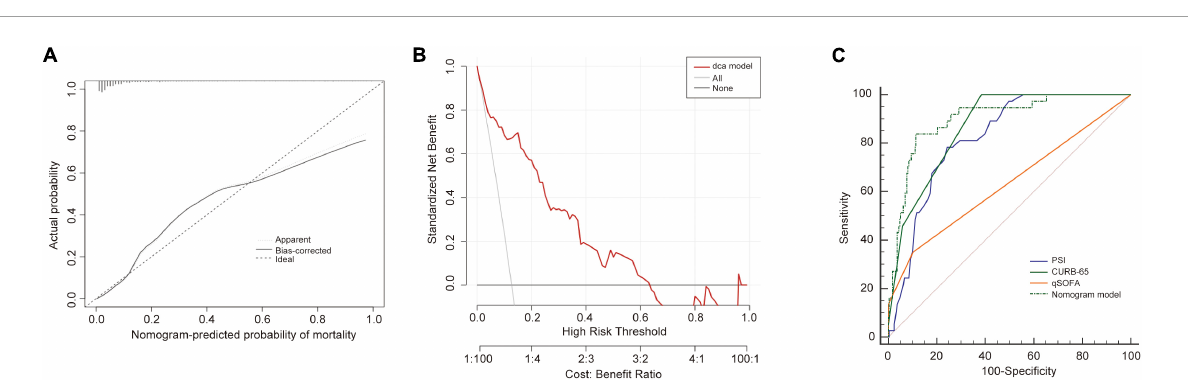
FIGURE5 Validation of the nomogram in validation cohort set. (A) Calibration curves for predicting the mortality in the validation set. (B) Decision curve analysis for the nomogram model in the validation set. (C) The receiver operator characteristic curves (ROC) of the nomogram model, PSI, CURB-65 and qSOFA in validation cohort for predicting the risk of mortality in the elderly with CAP. CURB-65: confusion, urea, respiratory rate, blood pressure, and age ≥ 65 years; qSOFA, quick Sequential Organ Failure Assessment; PSI, Pneumonia Severity Index.